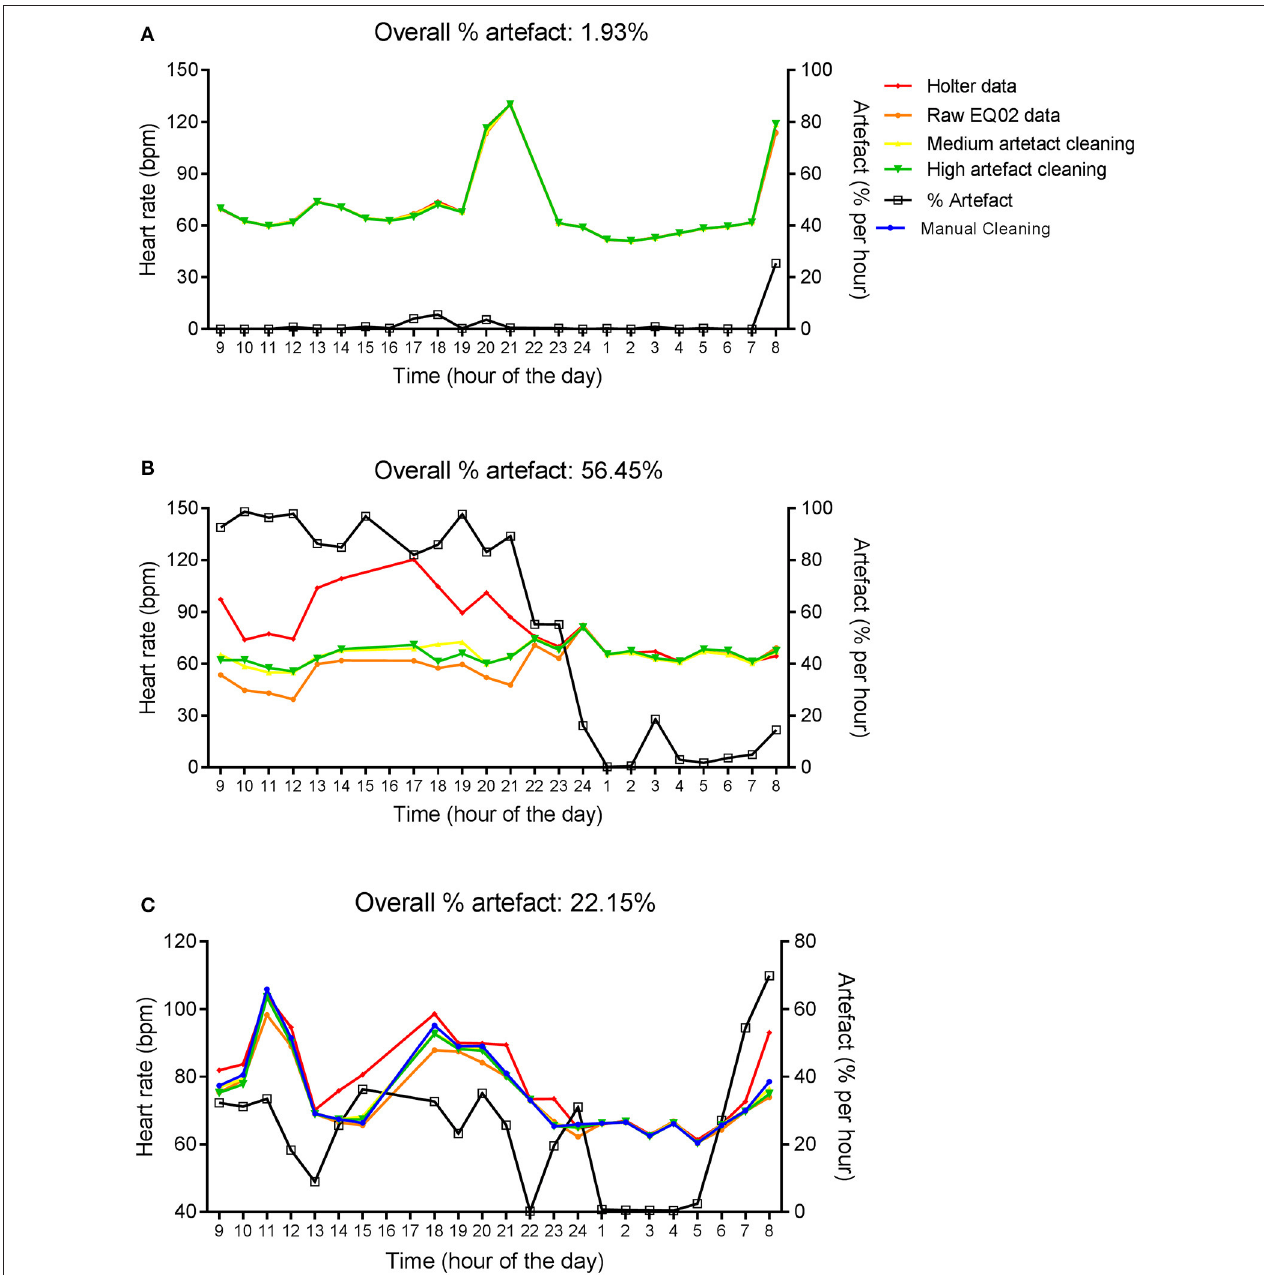
FIGURE 2 | Twenty four hour HR measurements by EQ02 and Holter. Hourly averages of HR measured simultaneously using the EQ02 and Holter monitors for three participants (A–C) . Raw EQ02 and automatically cleaned EQ02 data using the medium and high artifact sensitivity options of the Vivosense software are displayed. Artifact percentages over 24h (above each graph) and per hour (right y-axis) are